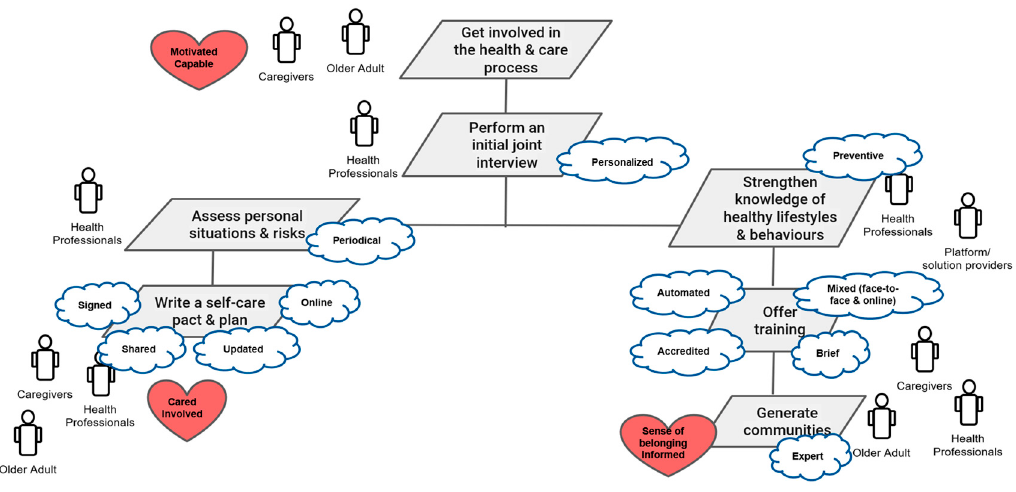
Figure 3. Representation of the Pharaon Murcia Pilot goal model “Get involved in the health and care process” [29].